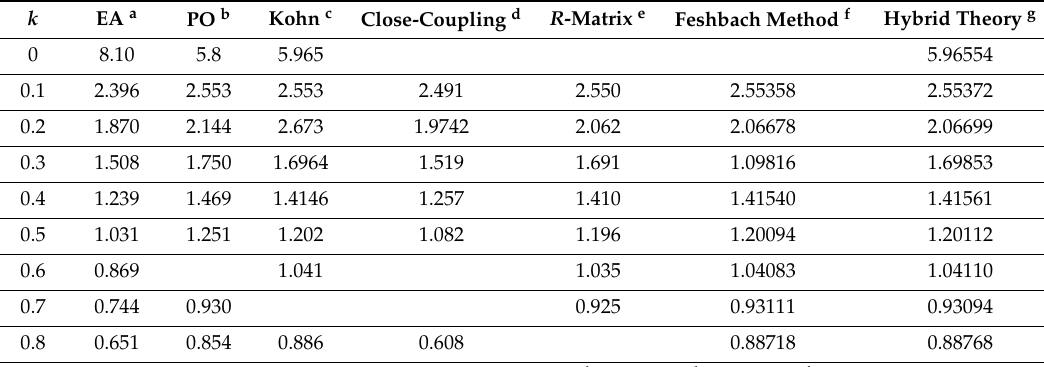
Table 1. Electron–hydrogen 1 S phase shifts (radians) obtained with di ff erent methods.